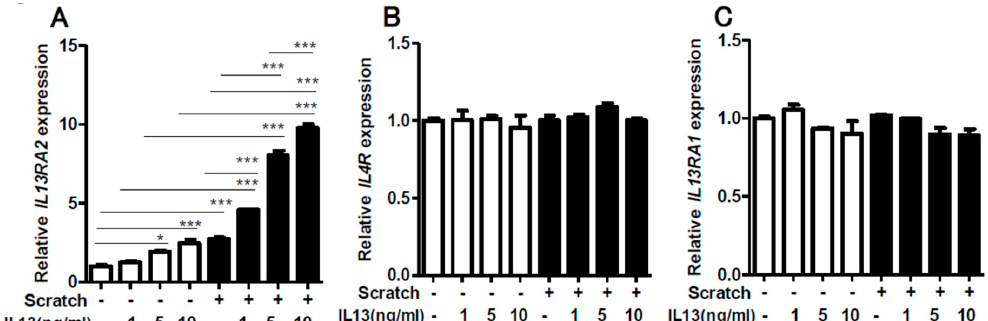
Figure 4. The effect of IL-13 on scratch-induced IL13RA2 ( A ), IL4R ( B ), and IL13RA1 ( C ) expression. Confluent keratinocyte sheets were non-scratched or scratched with 18 lines in the presence or absence of graded IL-13 concentrations (1, 5, 10 ng/mL). Cells were treated with IL-13 for 14 h before scratching and then incubated for another 6 h. Data is shown as the mean ± SEM. * p < 0.05, *** p < 0.001.